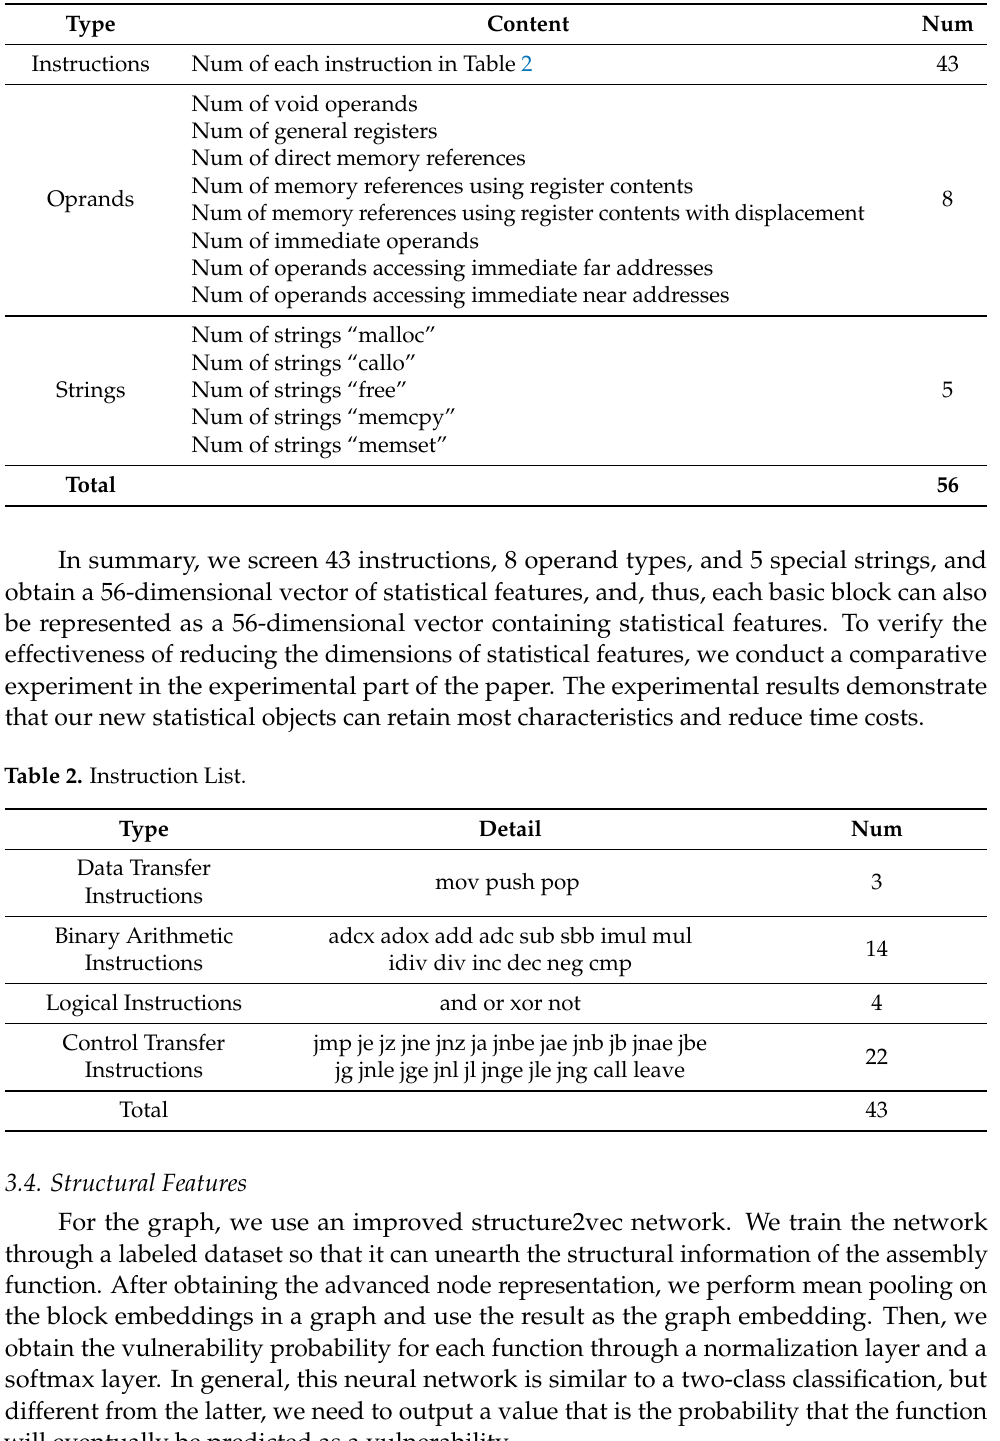
Table 1. List of statistical features.